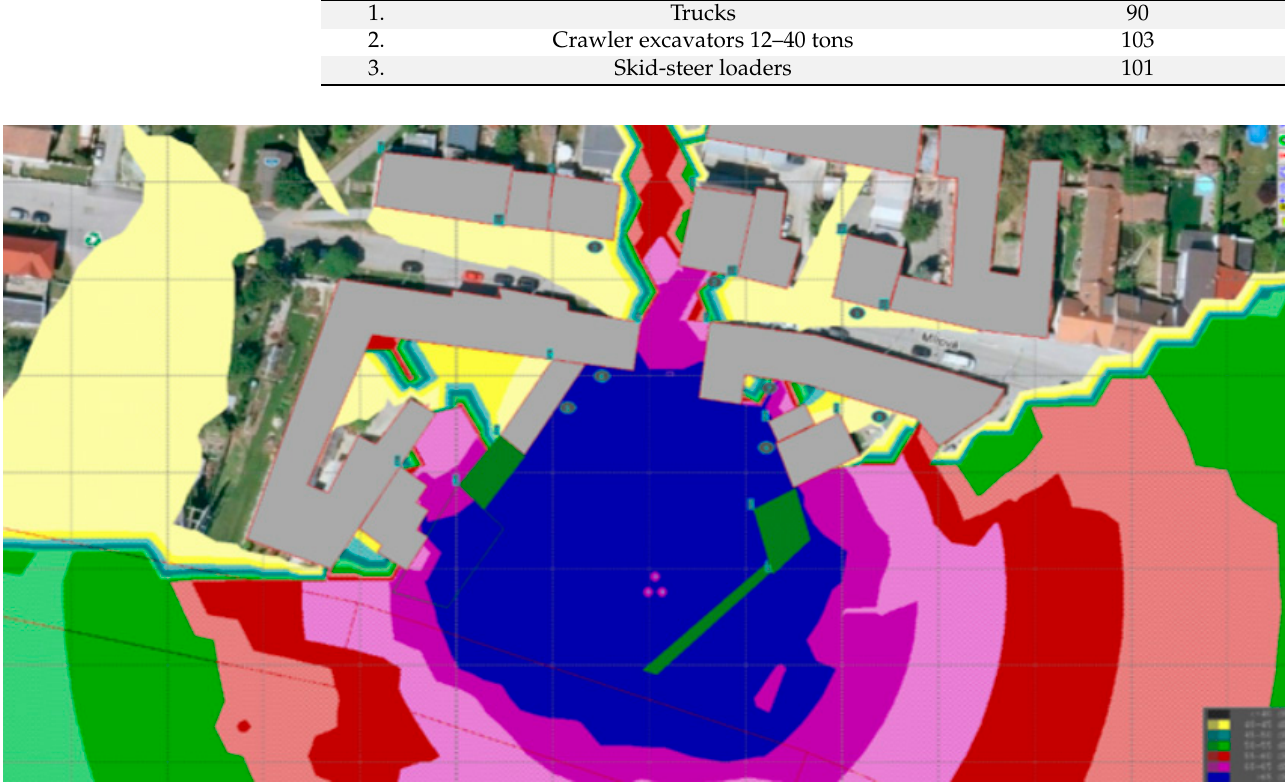
Figure 10. Colour map of isophone bands after the consideration of acoustically significant elements (without construction site fencing or a solid gate) for earthworks in the investigated area.